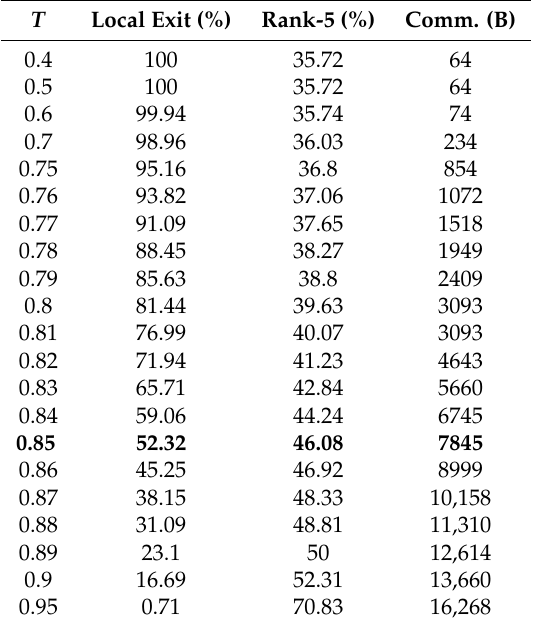
Figure 7. Line chart based on threshold T and local exit rate under 4 different segmentation methods. Table 2. While local network L = 7, the effects of different exit thresholds ( T ) settings for the local. T = 0.85 is used in L =